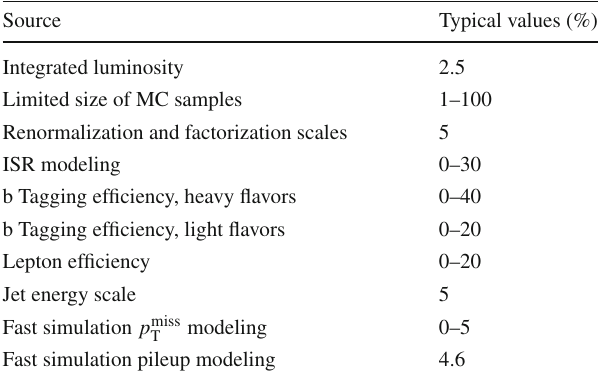
Table 3 Typical values of the systematic uncertainties as evaluated for the simplified models of SUSY used in the context of this search. The highstatisticaluncertaintyinthesimulatedsignalsamplecorrespondsto a small number of signal bins with low acceptance, which are typically not among the most sensitive signal bins to that model